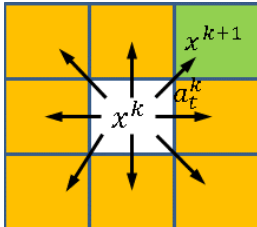
Figure 3. State-action space representation: The action set A consists of eight linear action a k